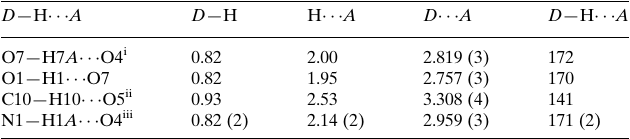
Hydrogen-bond geometry (A˚ , (cid:3)